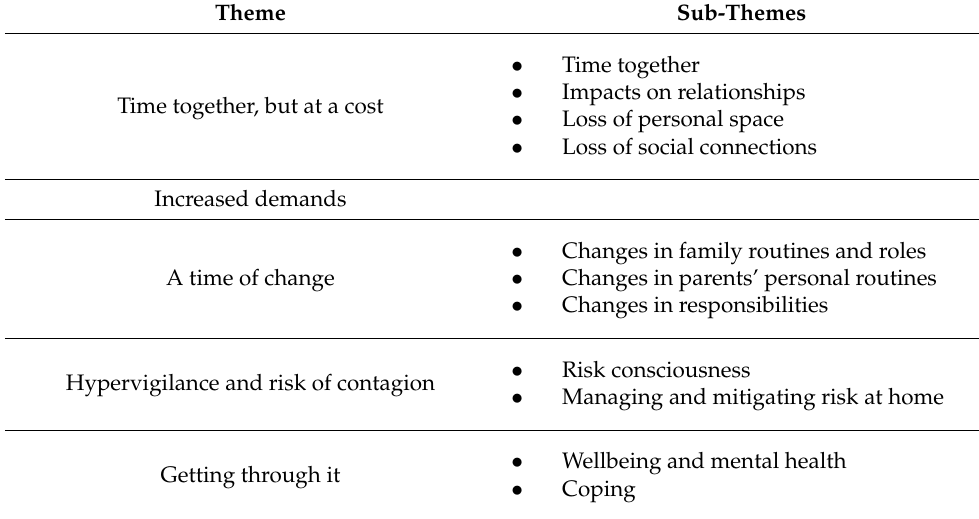
Table 2. Themes and subthemes